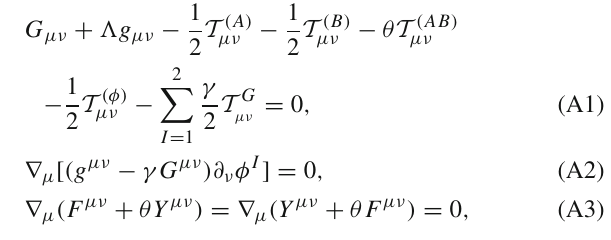
ˆ¯ L A as a function of ˆ k for different Horn-